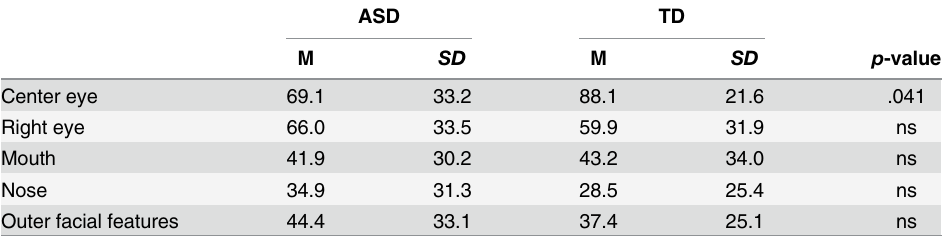
Table 2. Means (SD) of degree centrality by group for each AOI.